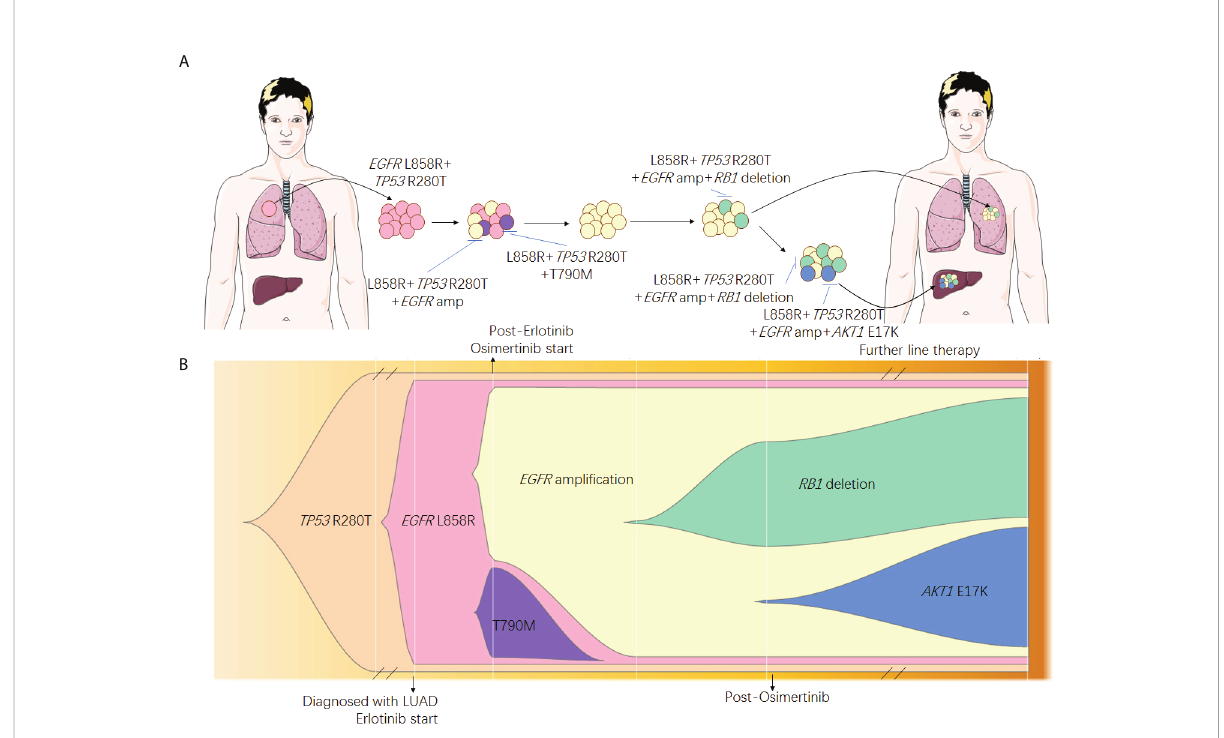
FIGURE 3 Speculated spatial heterogeneity (A) and evolutionary spectrum (B) of the